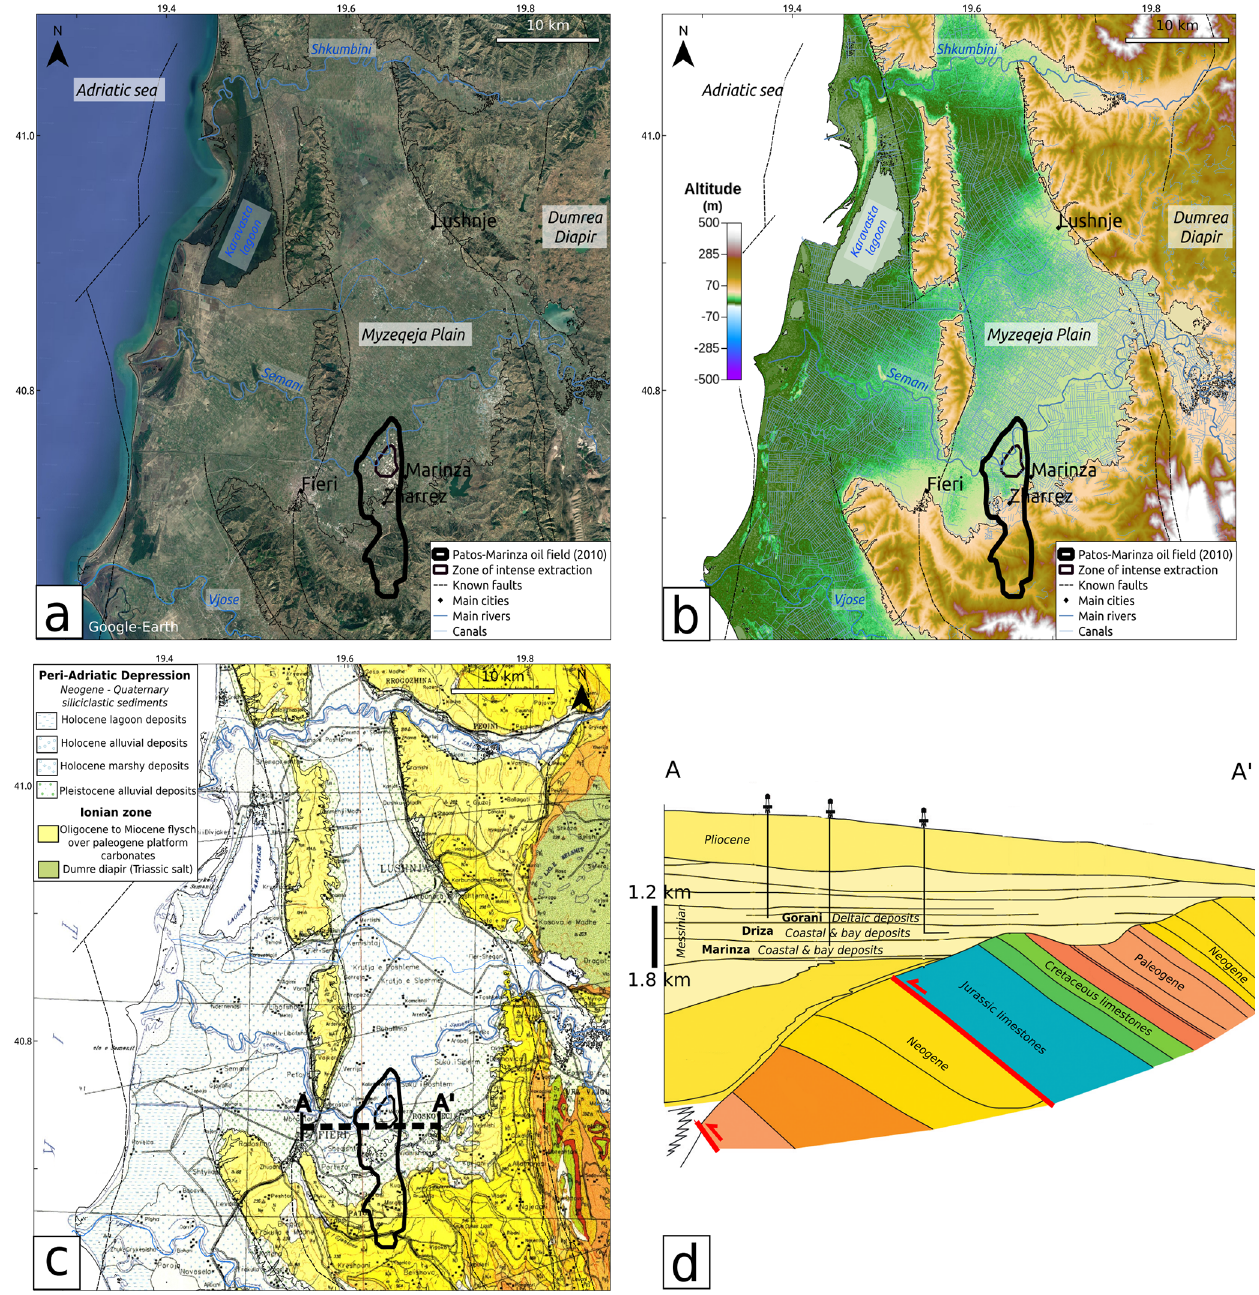
Figure 2. Anthropogenic, hydrological, and geological context of the study area. The Patos-Marinza active oil field (black bold line) is contoured based on BCP (2015). It encompasses the zone where wells are the densest and extraction activity concentrates (thin black line). Faults (black dashed lines) are from Aliaj et al. (2000). (a) Optical satellite image of the southern part of the Durres Basin in Fieri prefecture (satellite images from the ©Google Earth database). (b) Hydrology of the Myzeqeja plain. The network of constructed canals (in blue) is from TPGINC (2019) and is superimposed on the topography of the area (Farr and Kobrick, 2000). (c) Extract of the Geological Map of Albania (simplified from Xhomo et al., 2002). The dotted bold line is the approximate position of the simplified geological transect presented in panel (d) . (d) West–east interpreted geological cross section modified from Silo et al. (2013). The average depth of the Messinian sand- stone oil-bearing formations drilled in the northern part of the Patos-Marinza oil field is indicated together with the associated depositional environments. Faults in the underlying sedimentary series are plotted in